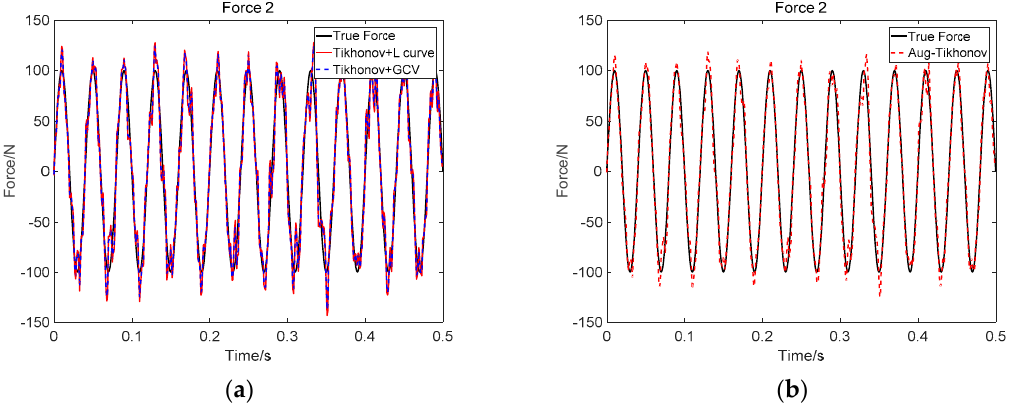
Figure 16. Identification result of two sinusoidal loads at SNR 30 dB (Force 1): ( a ) Tikhonov method; ( b ) the proposed method.